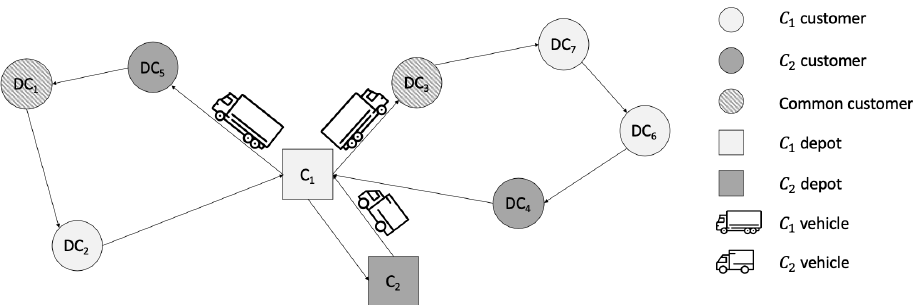
Figure 2. Graphical example of horizontal collaboration between the two suppliers.